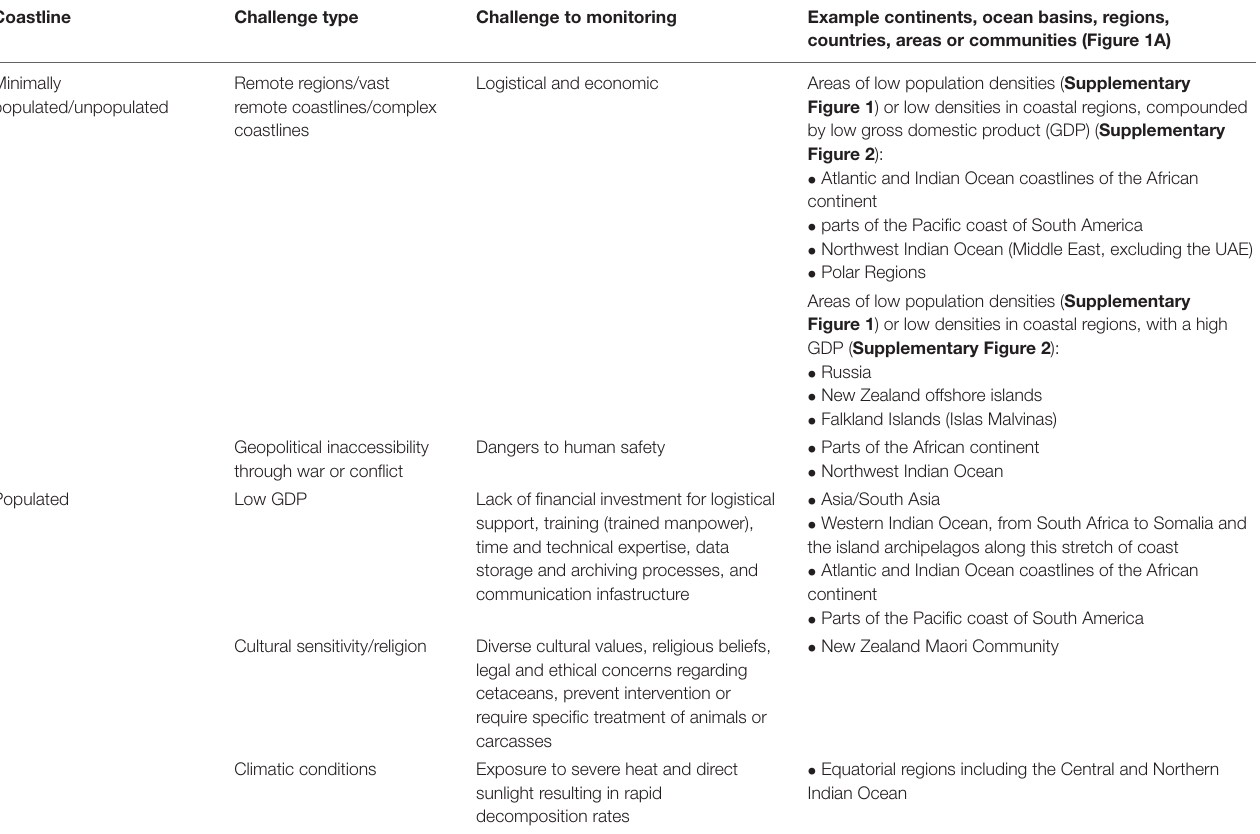
TABLE 1 | A table outlining the current challenges to stranding monitoring programmes through stranding networks, in both minimally populated/unpopulated areas and populated areas, with examples of continents, ocean basins, regions, countries, areas or communities.